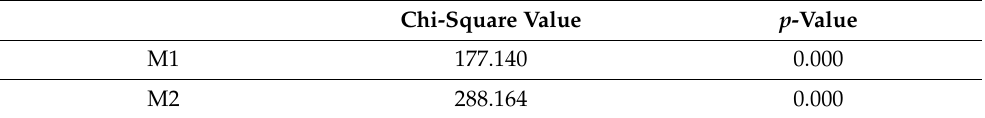
Table 3. Hausman test results.